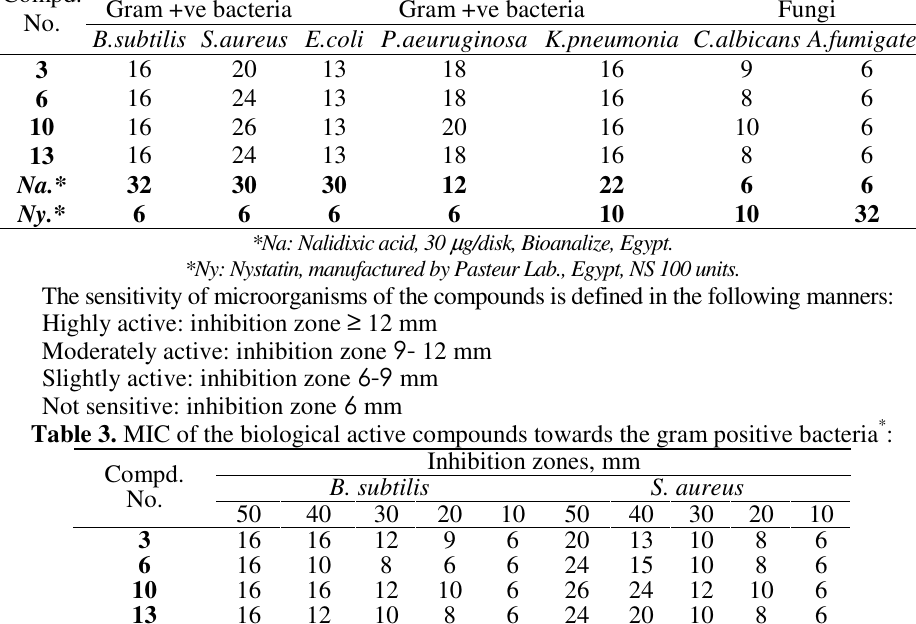
Table 2. The Preliminary screening of antimicrobial activity of the synthesized compounds Microorganisms / Inhibition Zone mm Compd. Gram +ve bacteria Fungi No.